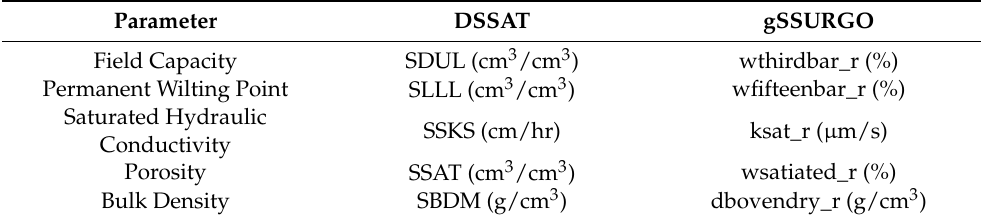
Figure 5. Example of gSSURGO Layer (For base layer: Map services and data available from U.S. Geological Survey, National Geospatial Program). Table 6. Soil parameter update from gSSURGO.